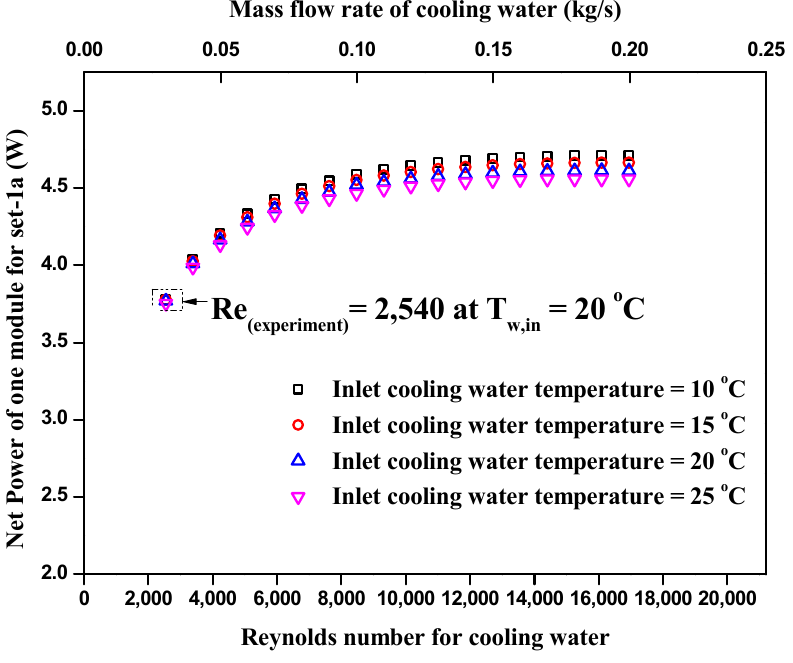
Figure 13. Variation in maximum net power output of one module of TEG set ‐ 1a.